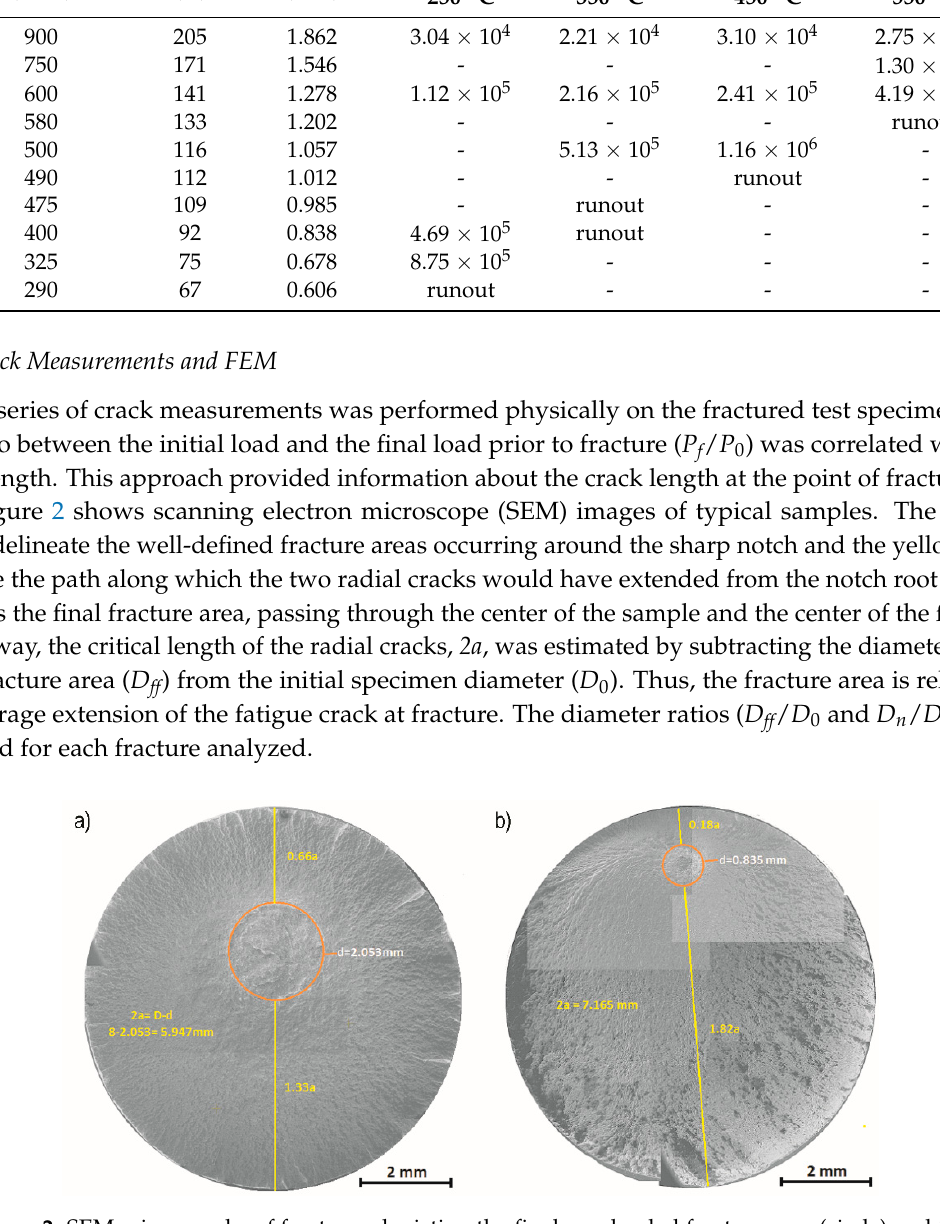
Figure 2. SEM micrographs of fractures depicting the final overloaded fracture area (circle) and the paths of two ideal cracks (lines). ( a ) High nominal stress; ( b ) low nominal stress. Finite element modeling (FEM) in ANSYS Workbench was used to obtain the load ratio, P n / P 0 , for several D n / D 0 ratios ranging from 0.3 to 1. The analysis was made with 67,795 nodes and 37,664 elements. The geometry was constrained from the grip area and a force was imposed at the free end. A static analysis was carried out in the original geometry to assess the deflection at the free end produced by different loads using an elastic modulus of 207 GPa. A crack at the notch root was introduced in a 2D model along the diameter with the crack tip towards the center (see Figure 3). The analysis was repeated using different crack sizes (depths) and constraining the part to the original deflection obtained for the uncracked specimen for each load without the crack. The reduced